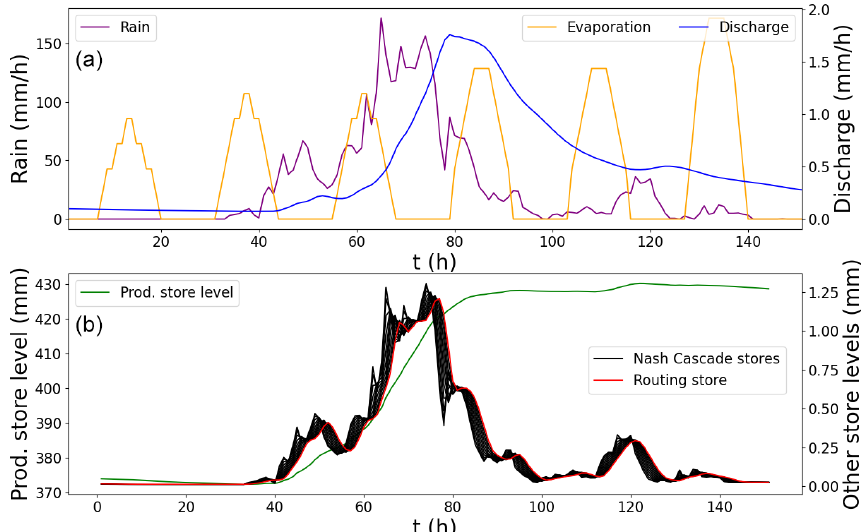
Figure 4. Evolution of GR4 inputs, output and reservoirs states during a sample rain event. (a) Temporal forcings (rain and evaporation) and modeled output (discharge). (b) Hydrological model states (reservoir levels).